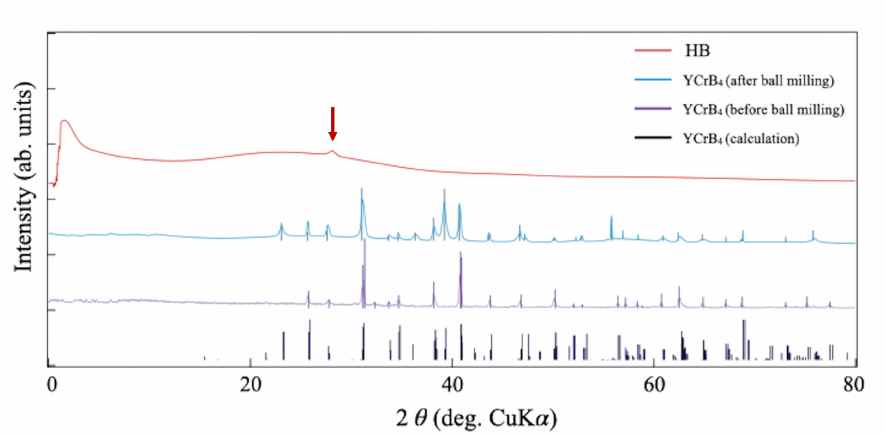
Figure 4. A collection of XRD patterns of the YCrB 4 crystals (before and after ball milling) and the HB powder. An arrow indicates a diffraction peak of the HB